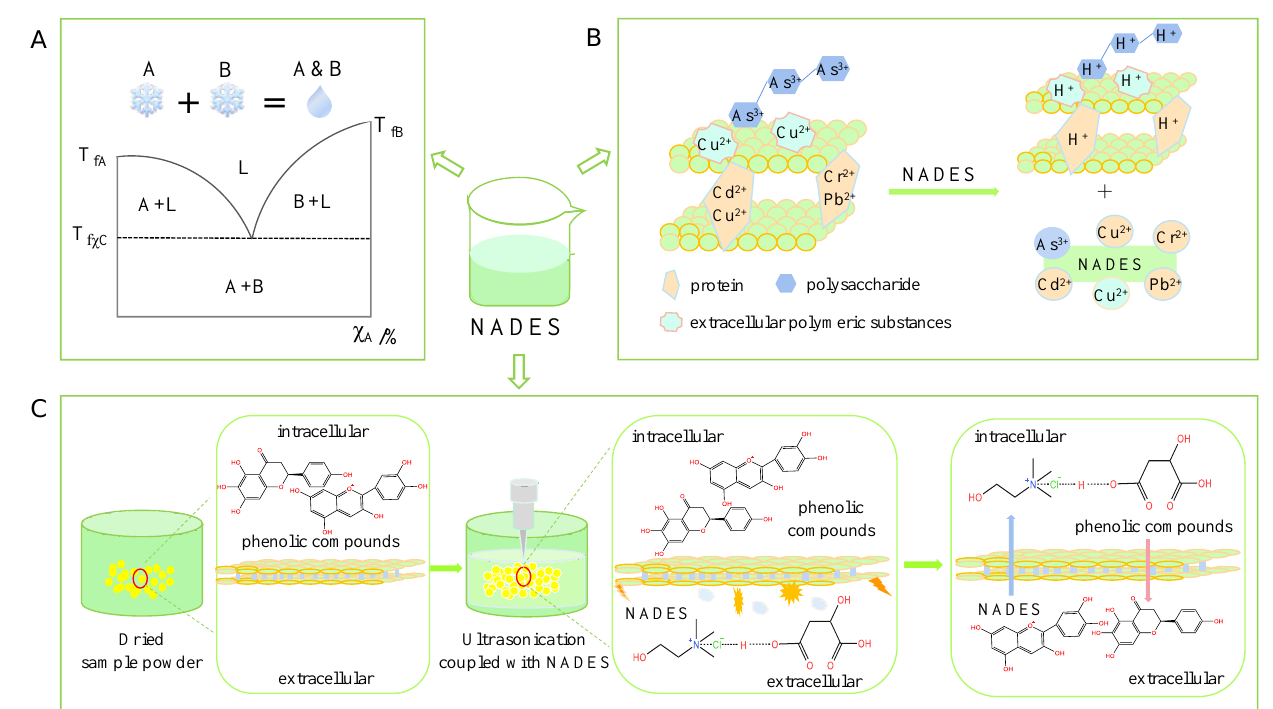
Figure 4. Mechanism of action of NADES. ( A ) Schematic phase diagram of the FP of NADES system [8]. χ A : the molar ratio of A to B (%); L: the mixture of A and B (liquid/liquid); A+B: the mixture of A and B (solid/solid); A+L: the mixture of A and B (liquid/solid or solid/liquid); B+L: the mixture of A and B (liquid/solid or solid/liquid); ( B ) removal of heavy metals from food by NADES [34,35]; ( C ) phenolic compounds were extracted by ultrasound-assisted NADES [36].